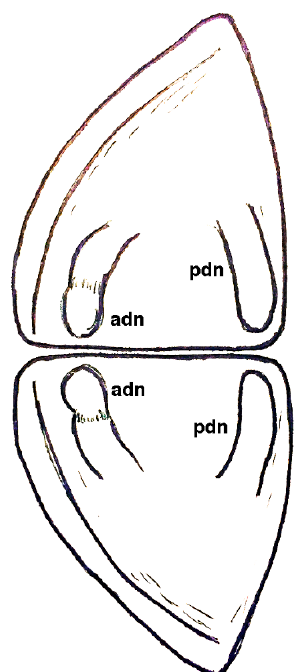
Figure 6. Beyrichona papilio . Paired shields shown in butterfly position. Anterior to left. Length of shield 3.6 mm. Abbreviations: adn , anterodorsal node; pdn , posterodorsal node. Image Credit: Mark McMenamin.